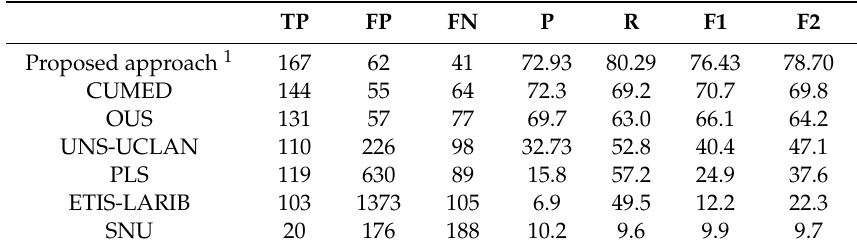
Table 5. Comparison of proposed approach with various state-of-the-art polyp localization methods on the ETIS-Larib database.